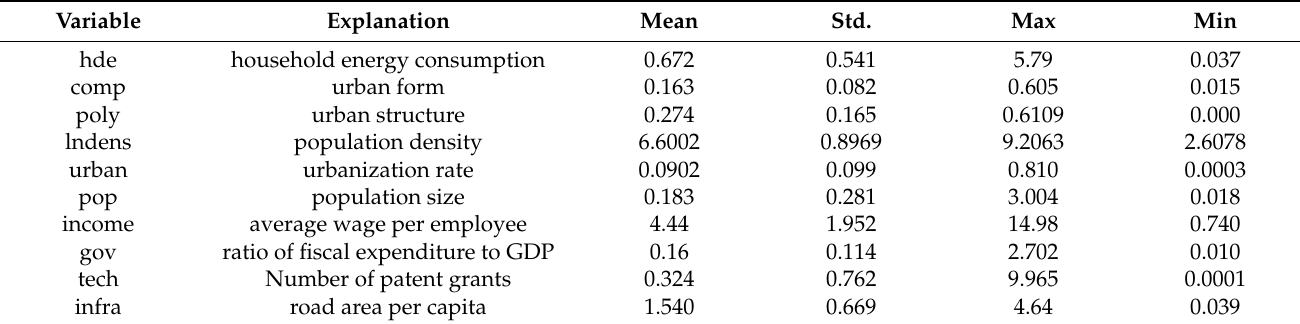
Table 2. Statistical description of